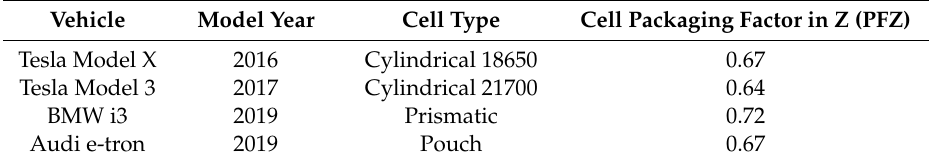
Table 5. Typical PFZ values for various vehicles and cell